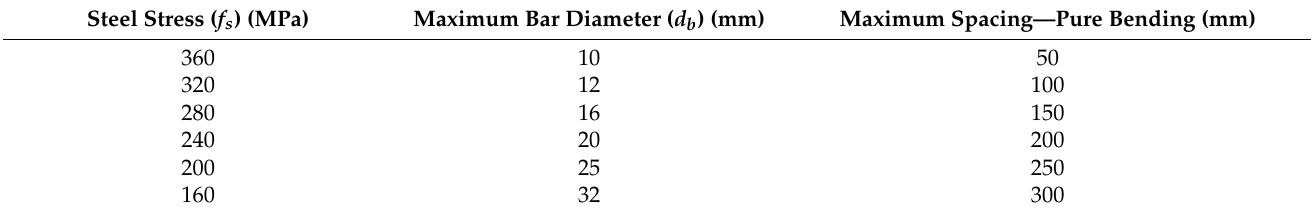
Table 1. Limitations of bar diameters and bar spacing set by Eurocode 2 to limit cracks.